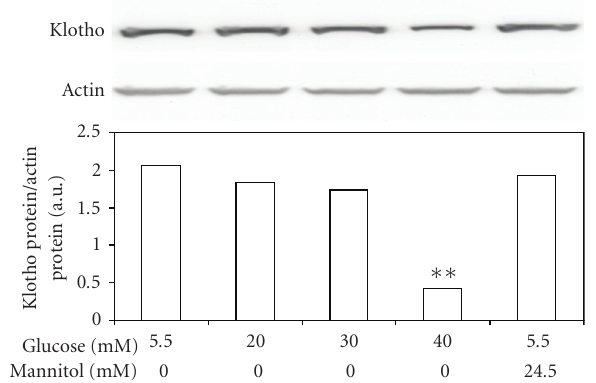
Figure 3: Changes in expression of Klotho in tubular cells (MDCK cells) after exposure to high concentrations of glucose. Cultured MDCK cells exposed to glucose at final concentrations of 10 mM, 20mM, 30 mM and 40 mM were used to compare with the control, which was incubated with 5.5 mM glucose. Cells were also exposed to 24.5 mM mannitol to produce the same osmolarity (317mOsmol/L) as that produced when using the highest concen- tration of glucose (30mM). After 24 hours of incubation, cells were prepared for Western blot analysis. Quantification of protein levels using Klotho over β -actin indicated as means with SE ( n = 4 per group) in each column are presented in the lower panel. ∗ P < . 05, ∗∗ P < . 001 compared to